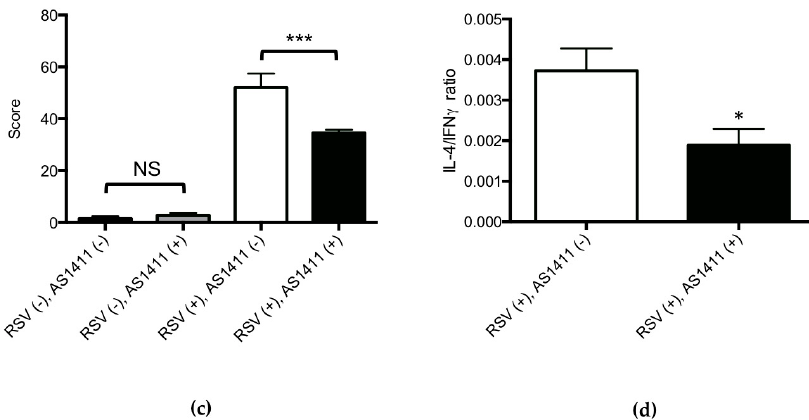
Figure 4. In Vivo mouse data demonstrating the efficacy of AS1411 in reducing viral infection. ( a ) AS1411 (50 mg/kg) given intranasally one day after RSV infection reduced lung virus levels by 0.3 log (~50%) on Day 4 (Mann–Whitney U test; ** p = 0.03); ( b ) Similar RSV-associated drop and recovery in body weight is obtained in infected animals with or without treatment with AS1411. AS1411 had no effect on body weight in uninfected animals (* p < 0.05, 2-way ANOVA with Bonferroni procedure). Significant difference seen between sets of points is due to RSV regardless of presence of absence of AS1411. Square: RSV (+), AS1411 (+); open triangle: RSV (+), AS1411 ( − ); open diamond: RSV ( − ), AS1411 (+); circle: RSV ( − ). AS1411 ( − ); ( c ) AS1411 treatment decreased RSV-associated airway inflammation (*** p = 0.009; Kruskal–Wallis test with Bonferroni procedure) and did not affect airway pathology in uninfected animals (NS = not significant); ( d ) In RSV-infected animals, AS1411 treatment was associated with a significantly decreased IL-4/IFN- γ ratio (* p < 0.05; Mann-Whitney u test), considered to be a beneficial anti-RSV host response [36,37].